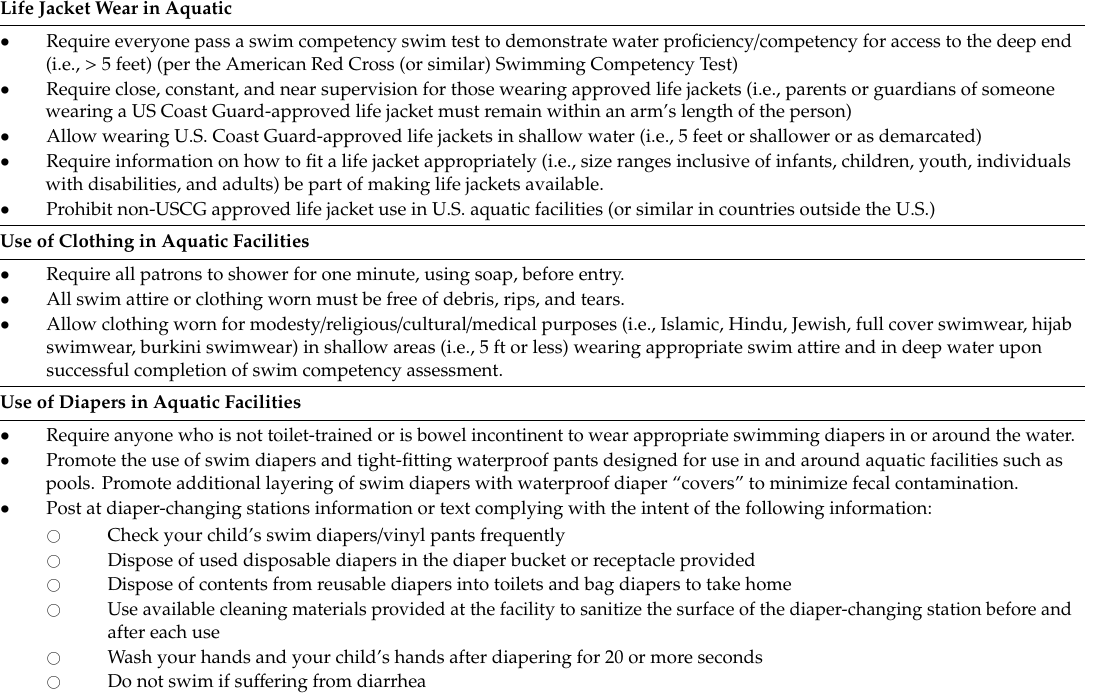
Table 3. Recommended guidelines for use of life jackets, clothing, and diapers in aquatic